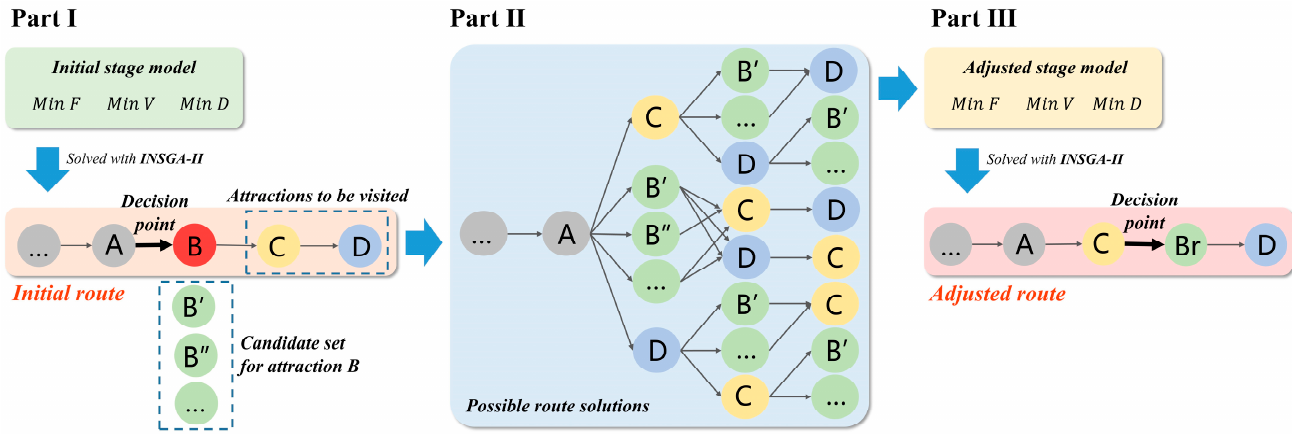
Figure 3. Process of the two-stage route strategy.